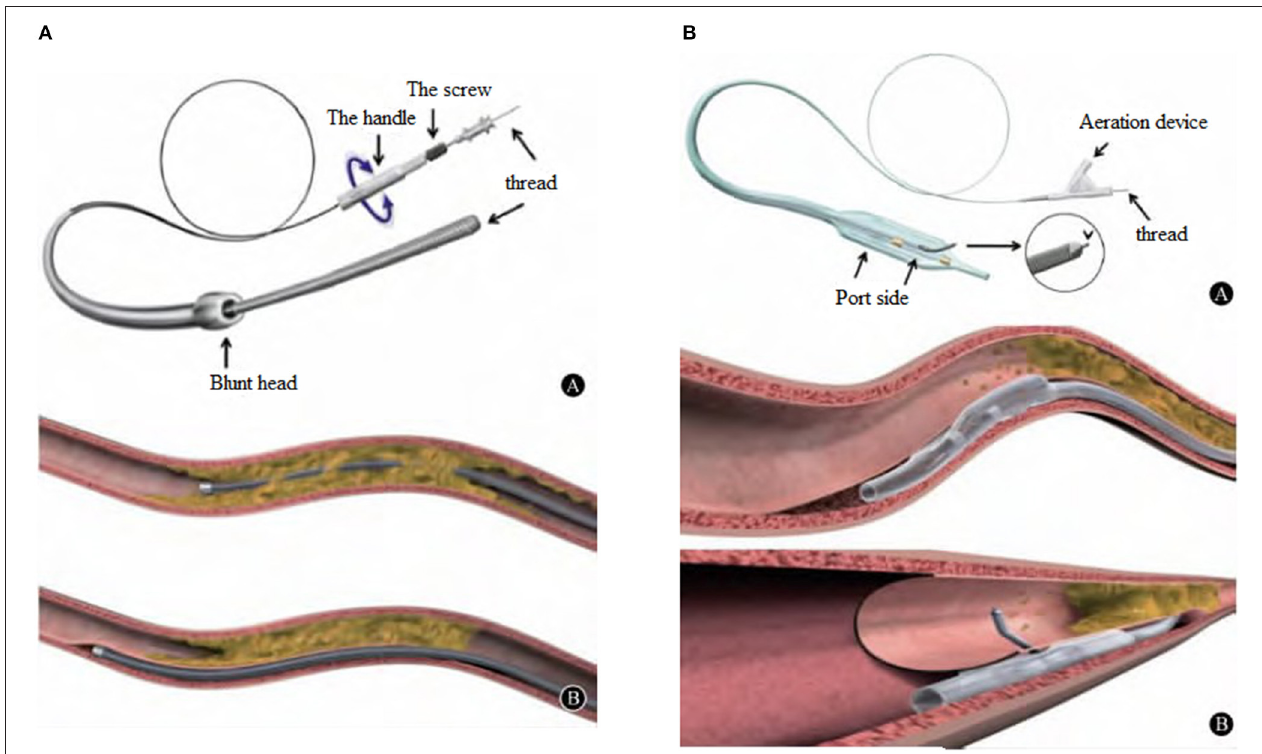
FIGURE 1 | (A) , CrossBoss TM penetrating catheter is provided by Boston Scientific Corporation in the U.S.A., with an outer diameter of 6F. Blunt tip, 3F (1mm) in diameter, this design allows the surgeon to use the “Fast-spin” torsion control device of the tail to quickly rotate for antegrade dissection and pass through the occlusion to reach a relatively normal blood vessel. (B) , CrossBoss TM catheter can open the CTO lesion in two ways: One is to pass through the lumen of the blood vessel directly, and the other is to enter and open the subintimal